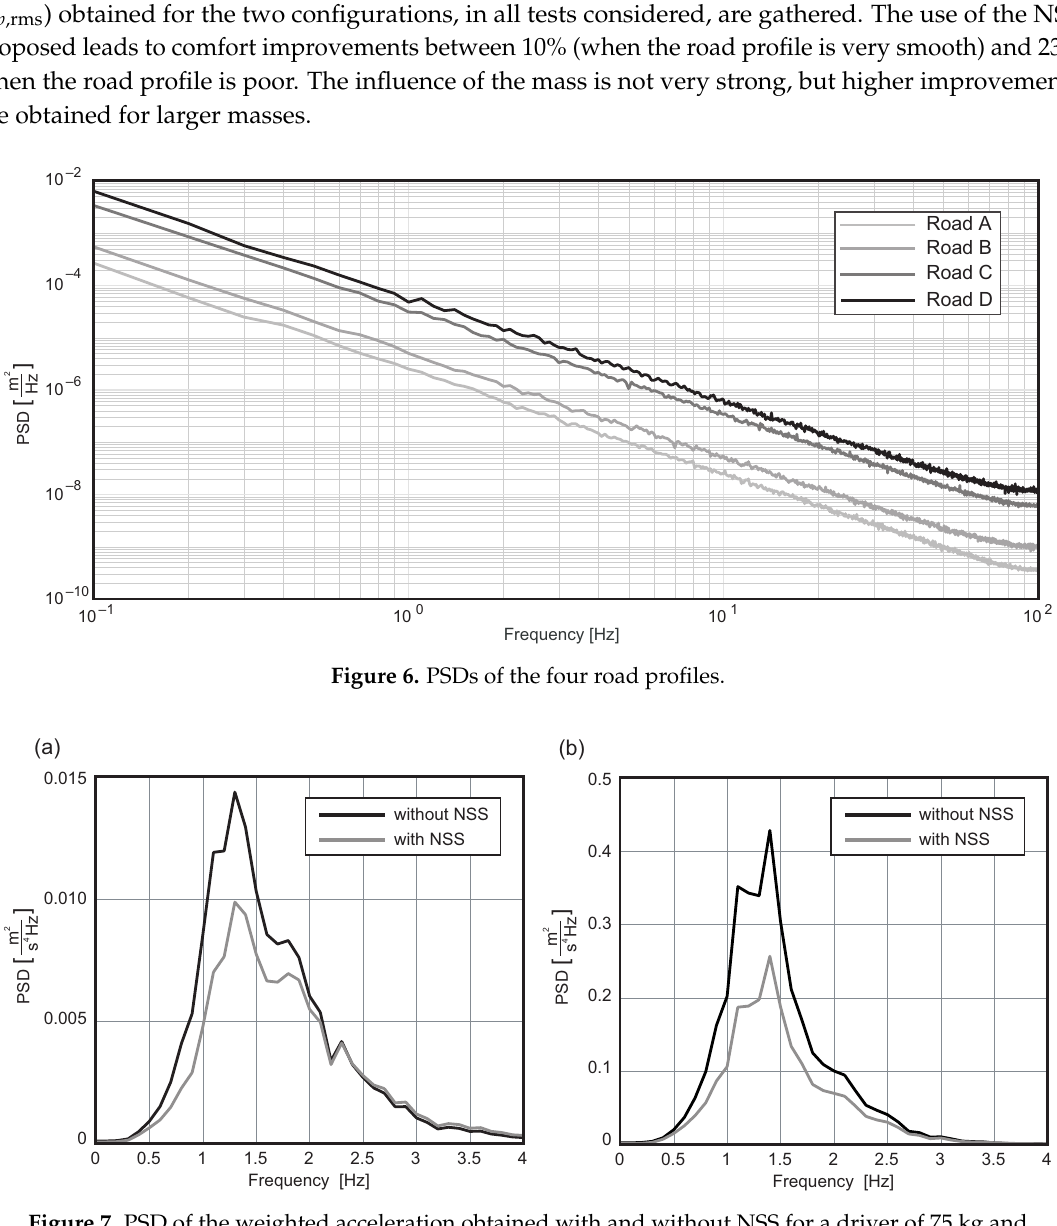
Figure 7. PSD of the weighted acceleration obtained with and without NSS for a driver of 75 kg and two different road profiles: ( a ) Type A and ( b ) Type